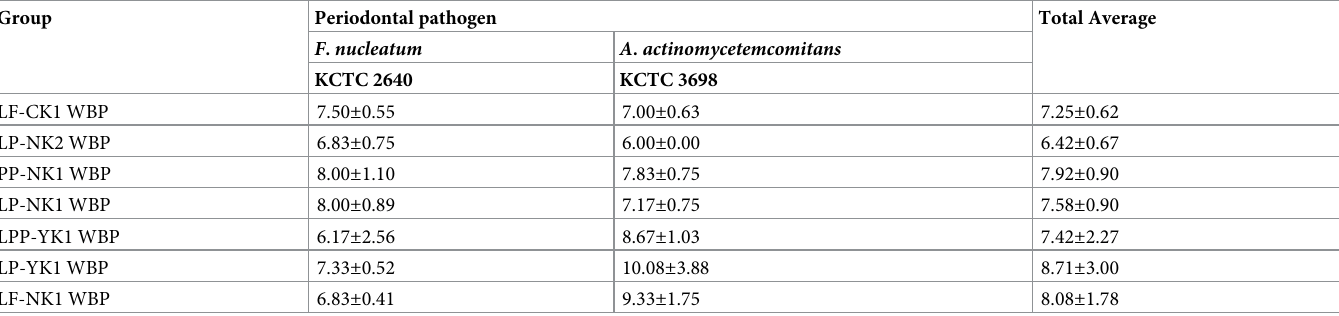
Table 2. Sizes (mean ± standard deviation; mm) of clear zones formed by seven whey bioconversion products against periodontal pathogens.